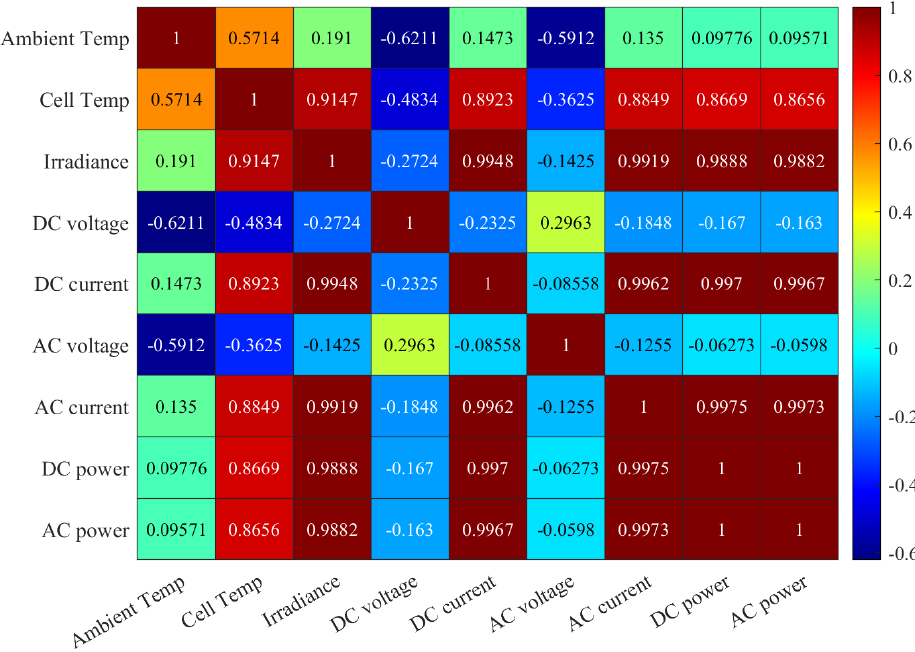
Figure 6. A Pearson correlation heatmap of